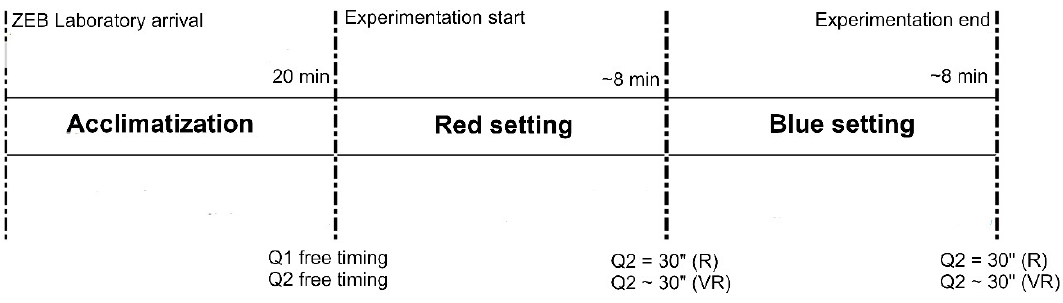
Figure 4. Timing of the experimentation.